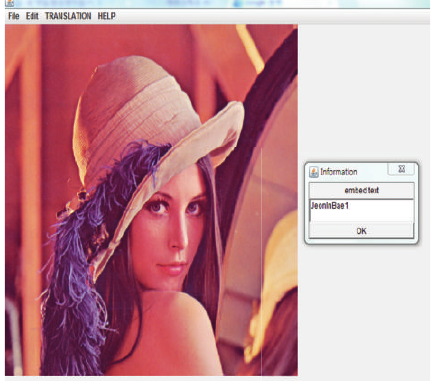
Figure 8: Screen for insertion of watermark text.